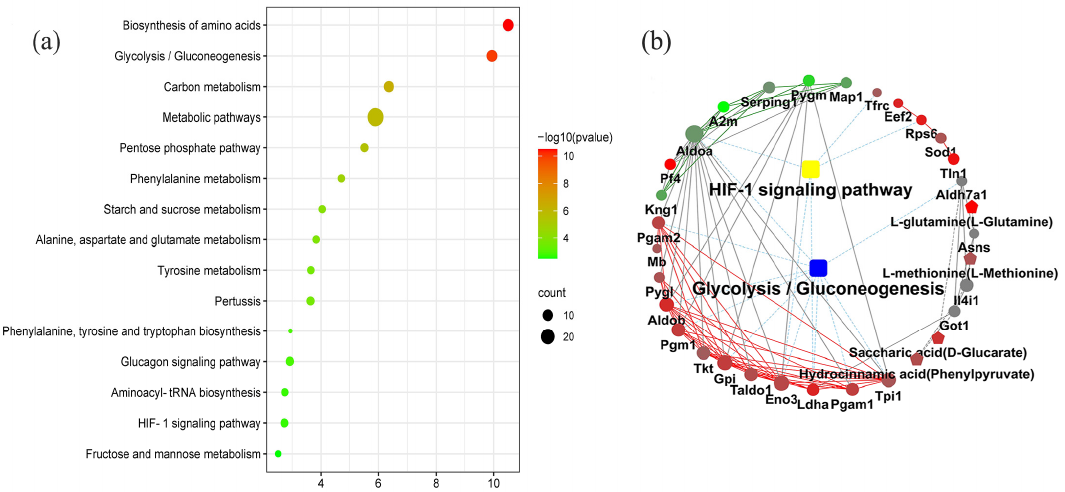
Figure 2. The top 15 coexpression KEGG pathways integrated proteomics and metabolomics using the OmicsBean, FDR < 0.05 ( a ). Proteins and metabolites interaction network diagram obtained from the OmicsBean platform show the differentially expressed proteins and metabolites related to the HIF-1 signaling pathway and glycolysis/gluconeogenesis pathway in the dental fluorosis group and control group ( b ). The samples included 6 dental fluorosis rats and 8 normal dental rats.